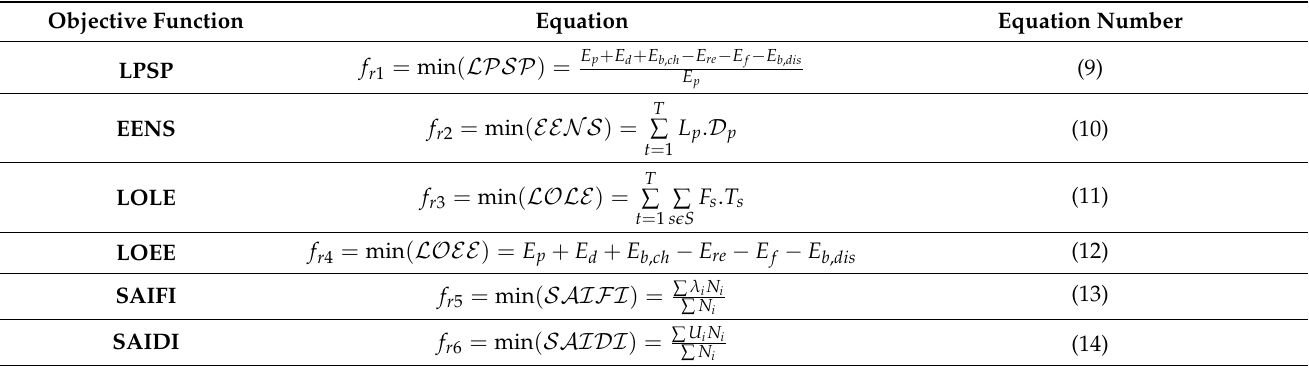
Table 2. The mathematical formulations of the reliability objective functions for the RAES optimal planning